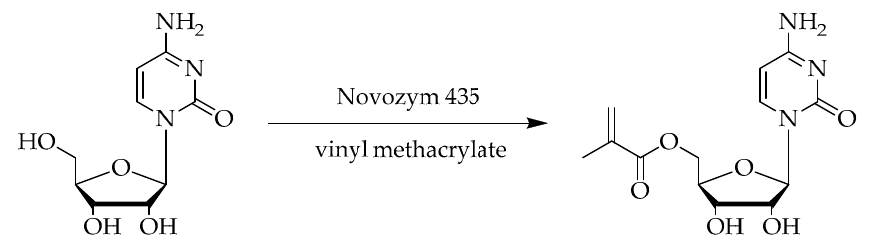
Figure 1. Enzyme-catalyzed synthesis of 5 ′ - O -methacryloylcytidine.